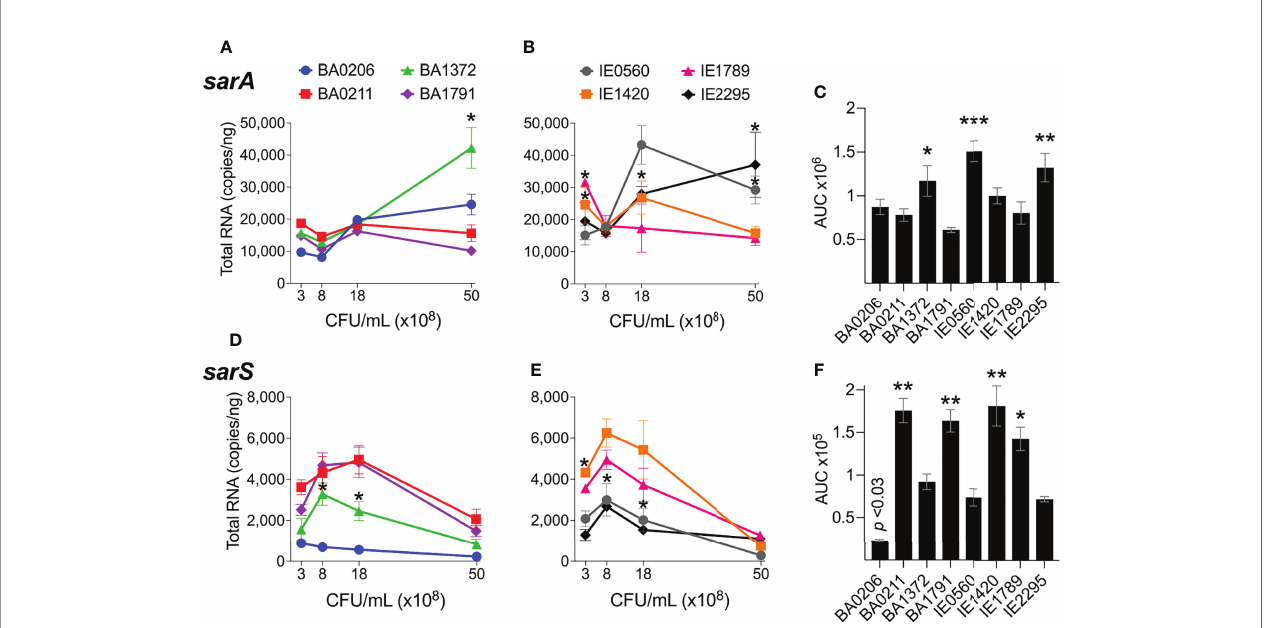
FIGURE 5 | sarA and sarS expression in S. aureus CC5 isolates. Figure 3 . Quantitation of S. aureus CC5 gene expression during growth in TH broth by RT-qPCR standard curve quantitation method. (A, B) sarA expression and (D, E) sarS expression at indicated cell densities. Error bars (standard deviation) not shown are smaller than symbol. Asterisks indicate data points signi fi cantly different than the rest at a speci fi c cell density. (C, F) Area under the curve (mean ± SEM). Data is the result of three biological replicates. *, p < 0.05, **, p < 0.005, ***, p < 0.0005, one-way ANOVA with Holm-S ̌ ı ́ da ́ k ’ s multiple comparisons test across